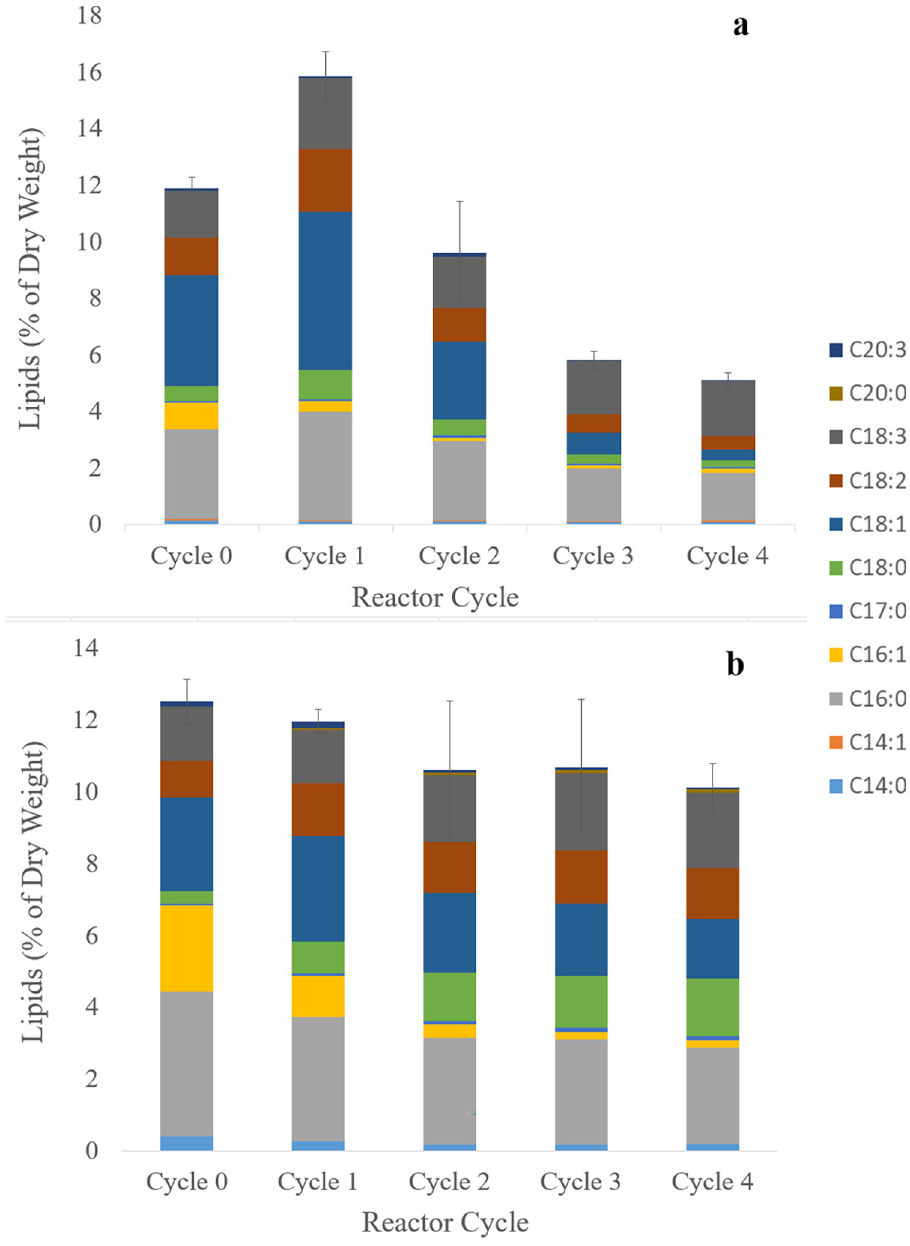
Fig 1. Lipid storage in algal biomass. Overall lipid content and FAME composition of a) pH 9 and b) pH 7.5 reactors over the course of feast-famine cycles. Error bars represent one standard deviation above and below of three biological